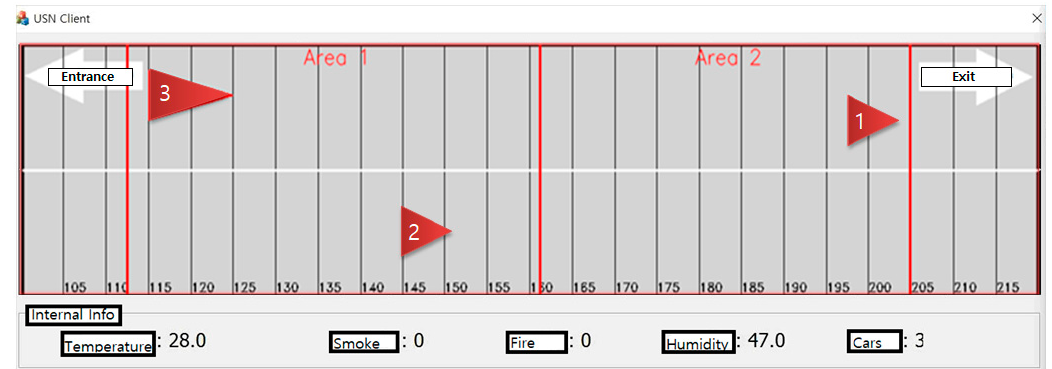
Figure 20. Traffic monitoring application using proposed radar system.